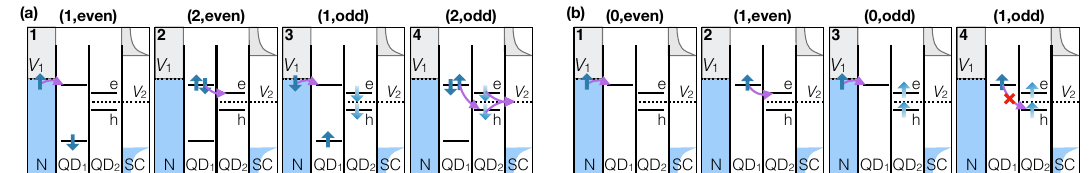
Figure 3: (a) Andreev transport cycle. QD is tuned to the 1-2 charge degeneracy 1 point, while QD is tuned to the vicinity of one of the charge degeneracy points, 2 such that even state is the ground state. The transport cycle consists of four charge states depicted in the Figure. The incoherent electron tunneling processes (which we describe using the master equation formalism) are depicted by purple arrows. Odd parity states of QD are depicted as superpositions of electron and hole states 2 to denote the approximate particle-hole symmetry (i.e. the fact that odd → even transition can occur via either electron addition or electron subtraction). (b) Andreev blockade. Setup identical to panel (a) except the QD is tuned to the 0-1 charge 1 degeneracy point. Andreev blockade occurs in the last step: QD and QD both host 1 2 a spin-up electron, consequently the spin-up electron on QD cannot tunnel onto QD 1 2 to make a Cooper